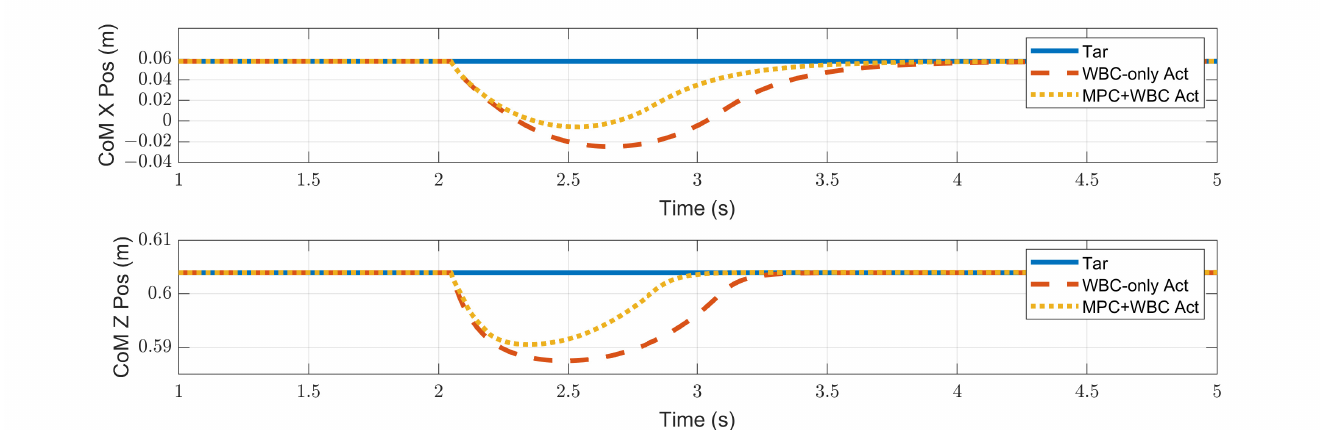
Figure 4. CoM position of the robot under the frontal impact of a 9 kg rigid ball.